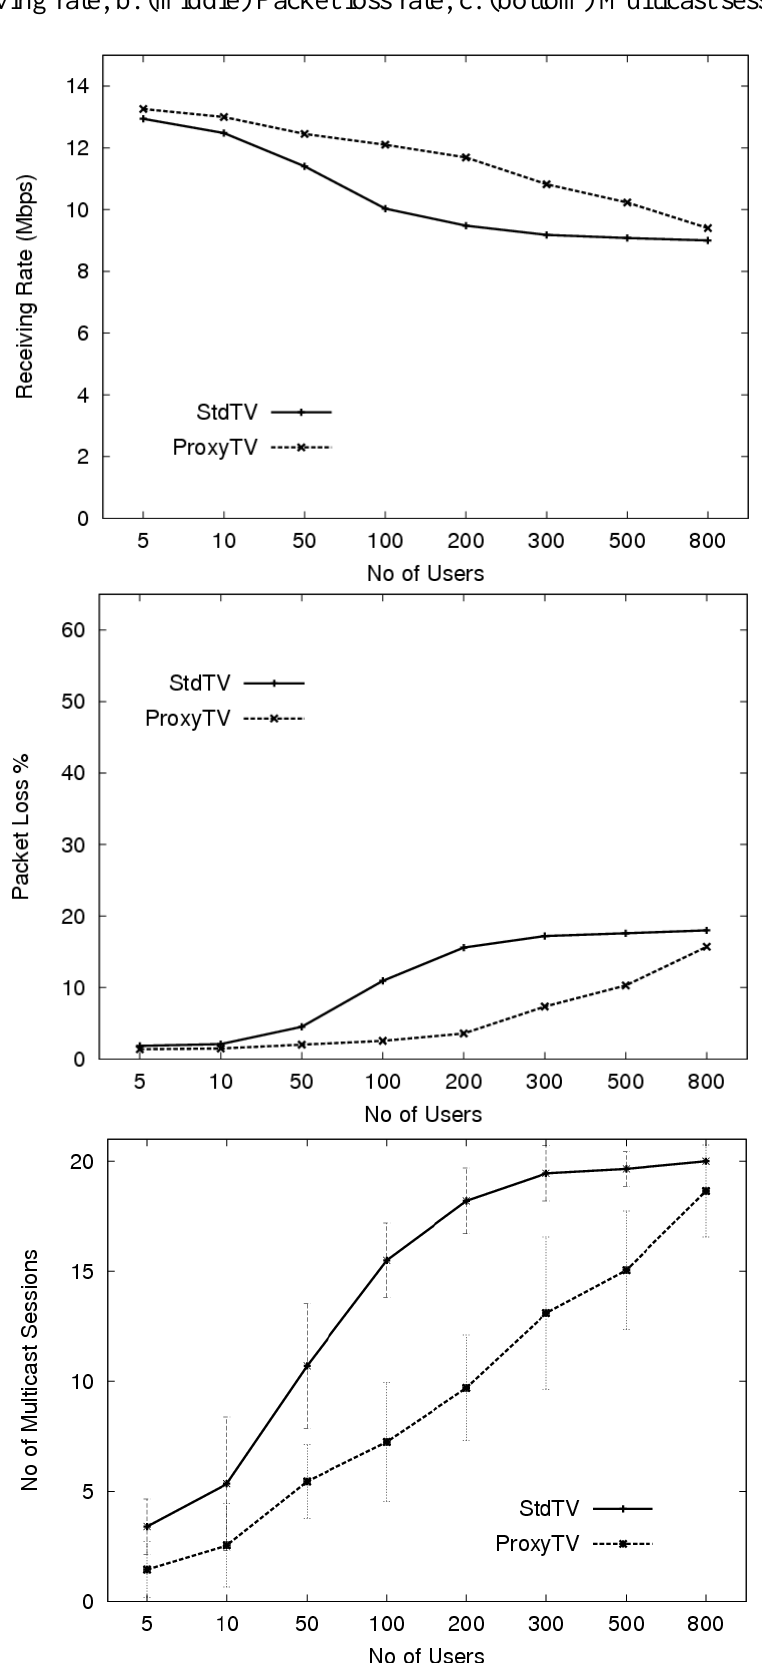
Figure 6. Statistical performances with and without ProxyTV (200 Mbps link bandwidth). a. (top) Receiving rate; b. (middle) Packet loss rate; c. (bottom) Multicast